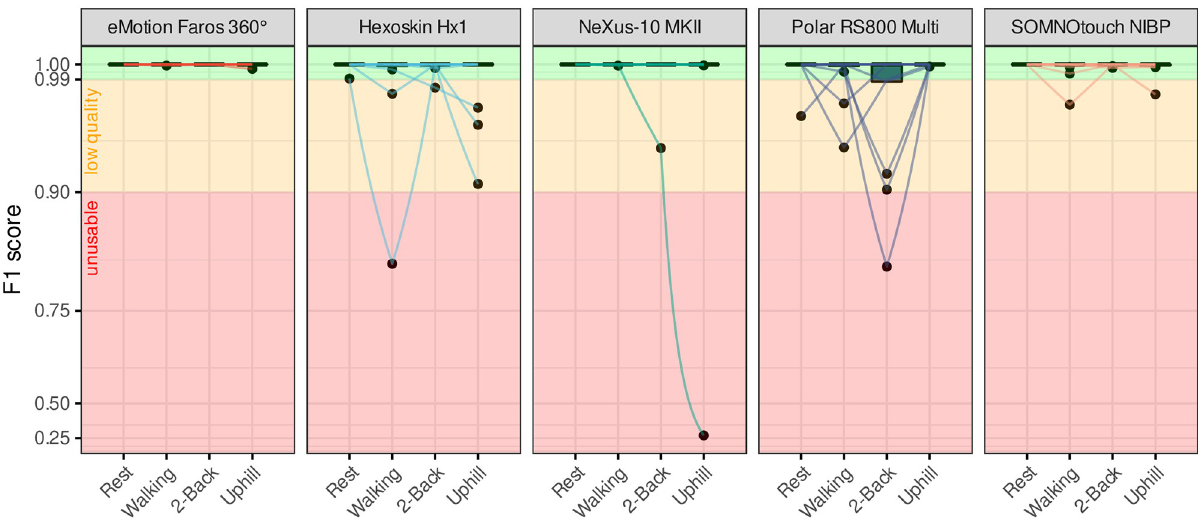
Fig 5. QRS detection performance expressed by F1 scores of the used devices per experimental phase with individual curve progression.